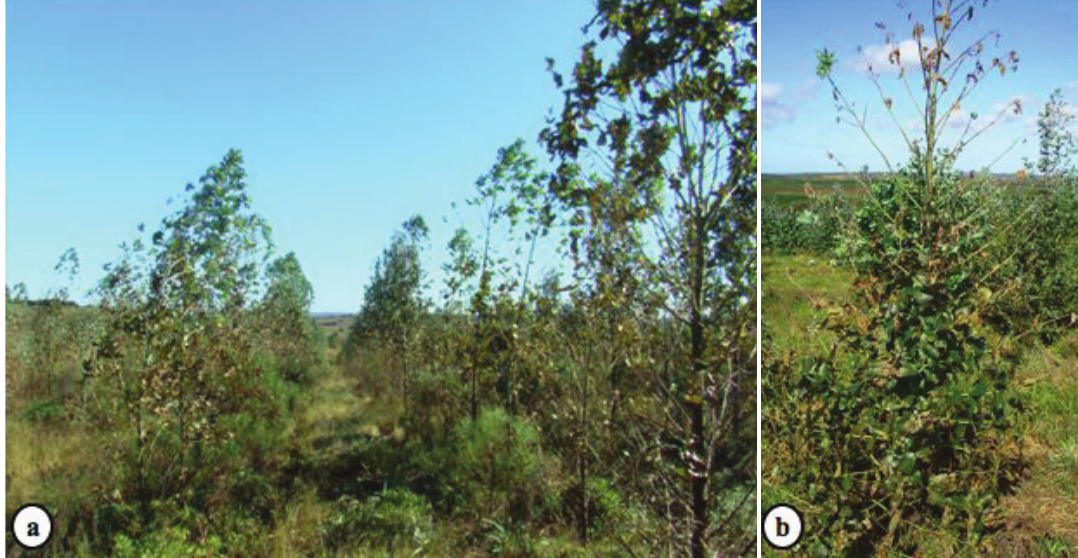
Fig. 2. Premature defoliation of young Eucalyptus globulus trees caused by Teratosphaeria nubilosa